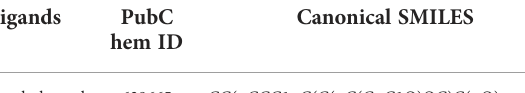
TABLE 5 PubChem ID and canonical SMILES of xanthohumol and anastrozole. Ligands PubC hem